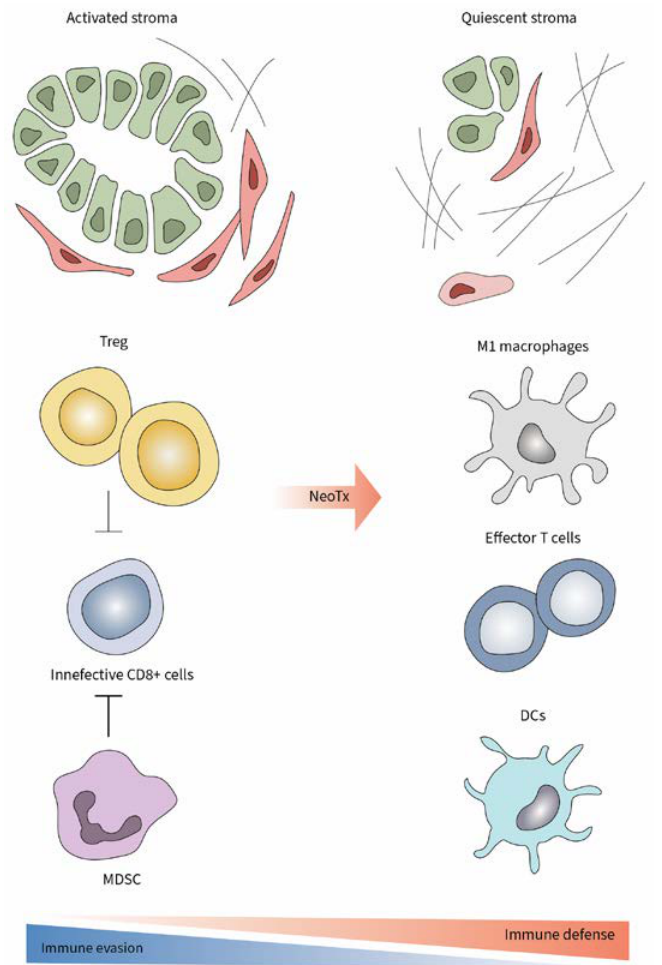
Figure 1. Enhancement of antitumor immune response and decreased stromal activation after neoTx in